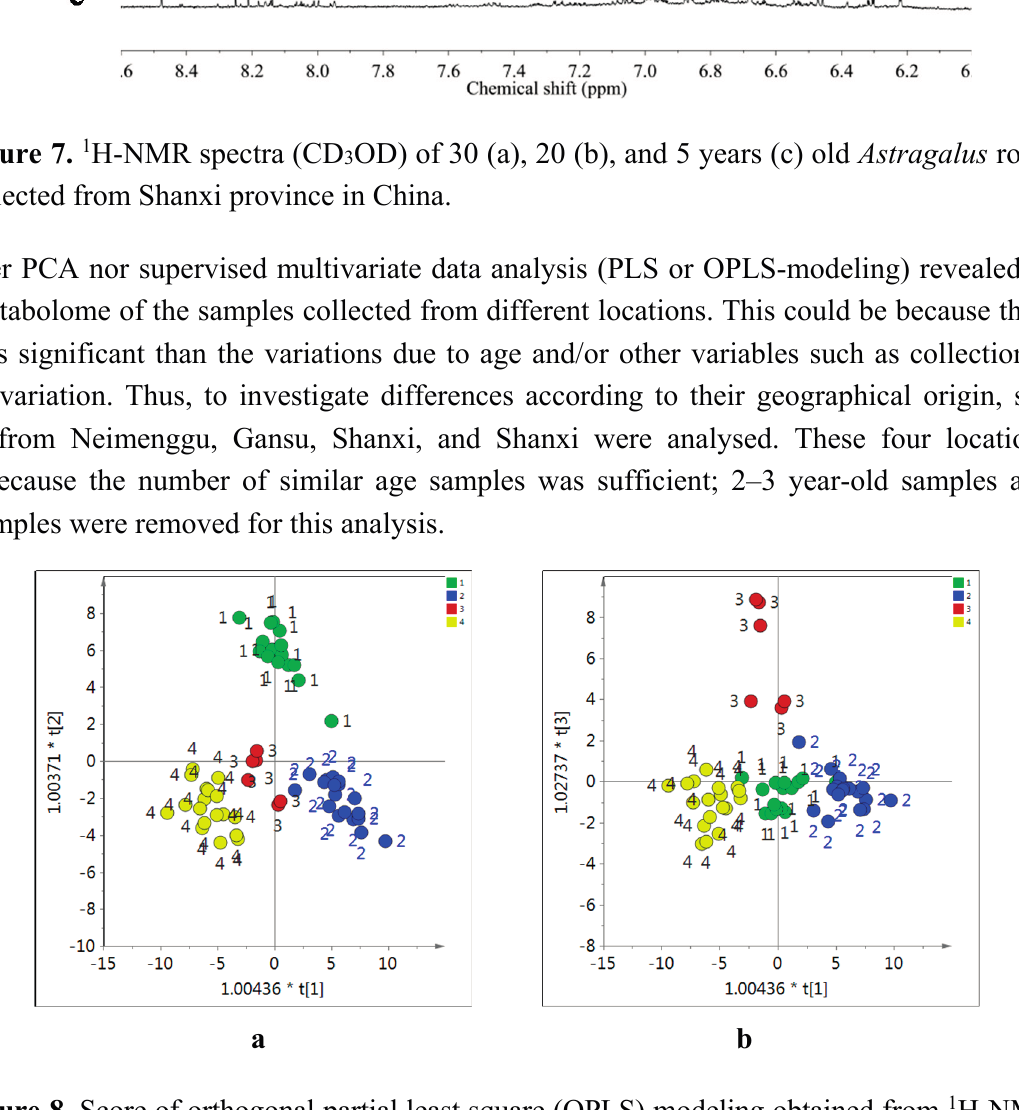
Figure 8. Score of orthogonal partial least square (OPLS) modeling obtained from 1 H-NMR data of in CD 3 OD extracts of Astragalus roots as X-data and locations of each sample as Y-data using the combination of OPLS component 1 and 2 ( a ) and 1 and 3 ( b ). 1: Neimengu, 2: Ganxu, 3: Shanxi, 4: Shaanxi in